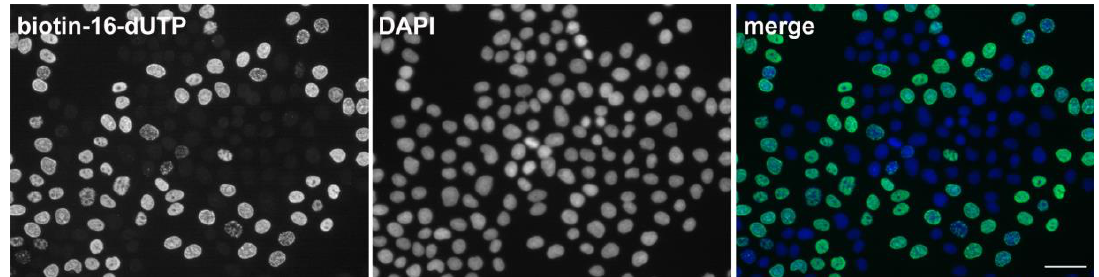
Figure 8. An example of labeling of DNA replication using biotin tagged deoxyuridine triphosphate. HeLa cells were hypotonically treated according to [119,121], fixed (2% formaldehyde, 10 min) and permeabilized (0.2% Triton X-100, 10 min). The biotin was detected using an anti-biotin primary antibody followed by the Alexa Fluor 488 anti-rabbit antibody (green in the color figure). The DNA was stained by DAPI (blue in the color figure). Bar: 50 µm.